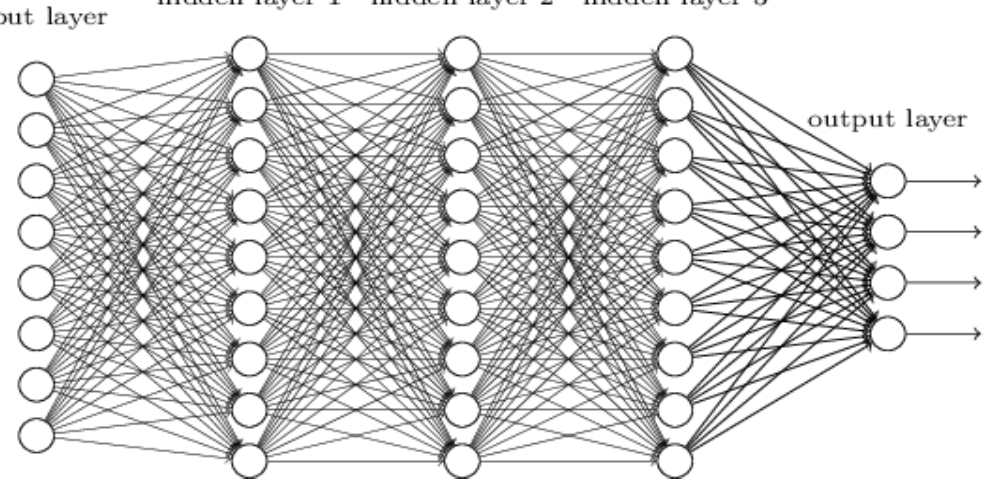
Fig. 1. Shape of the Convolutional neural